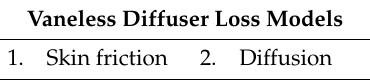
Table 4. Vaneless diffuser loss